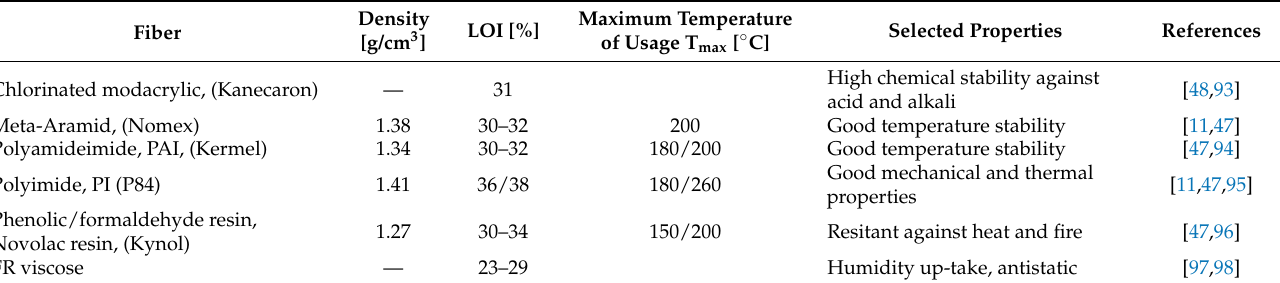
Table 3. Comparison of properties of some flame-retardant fibers.